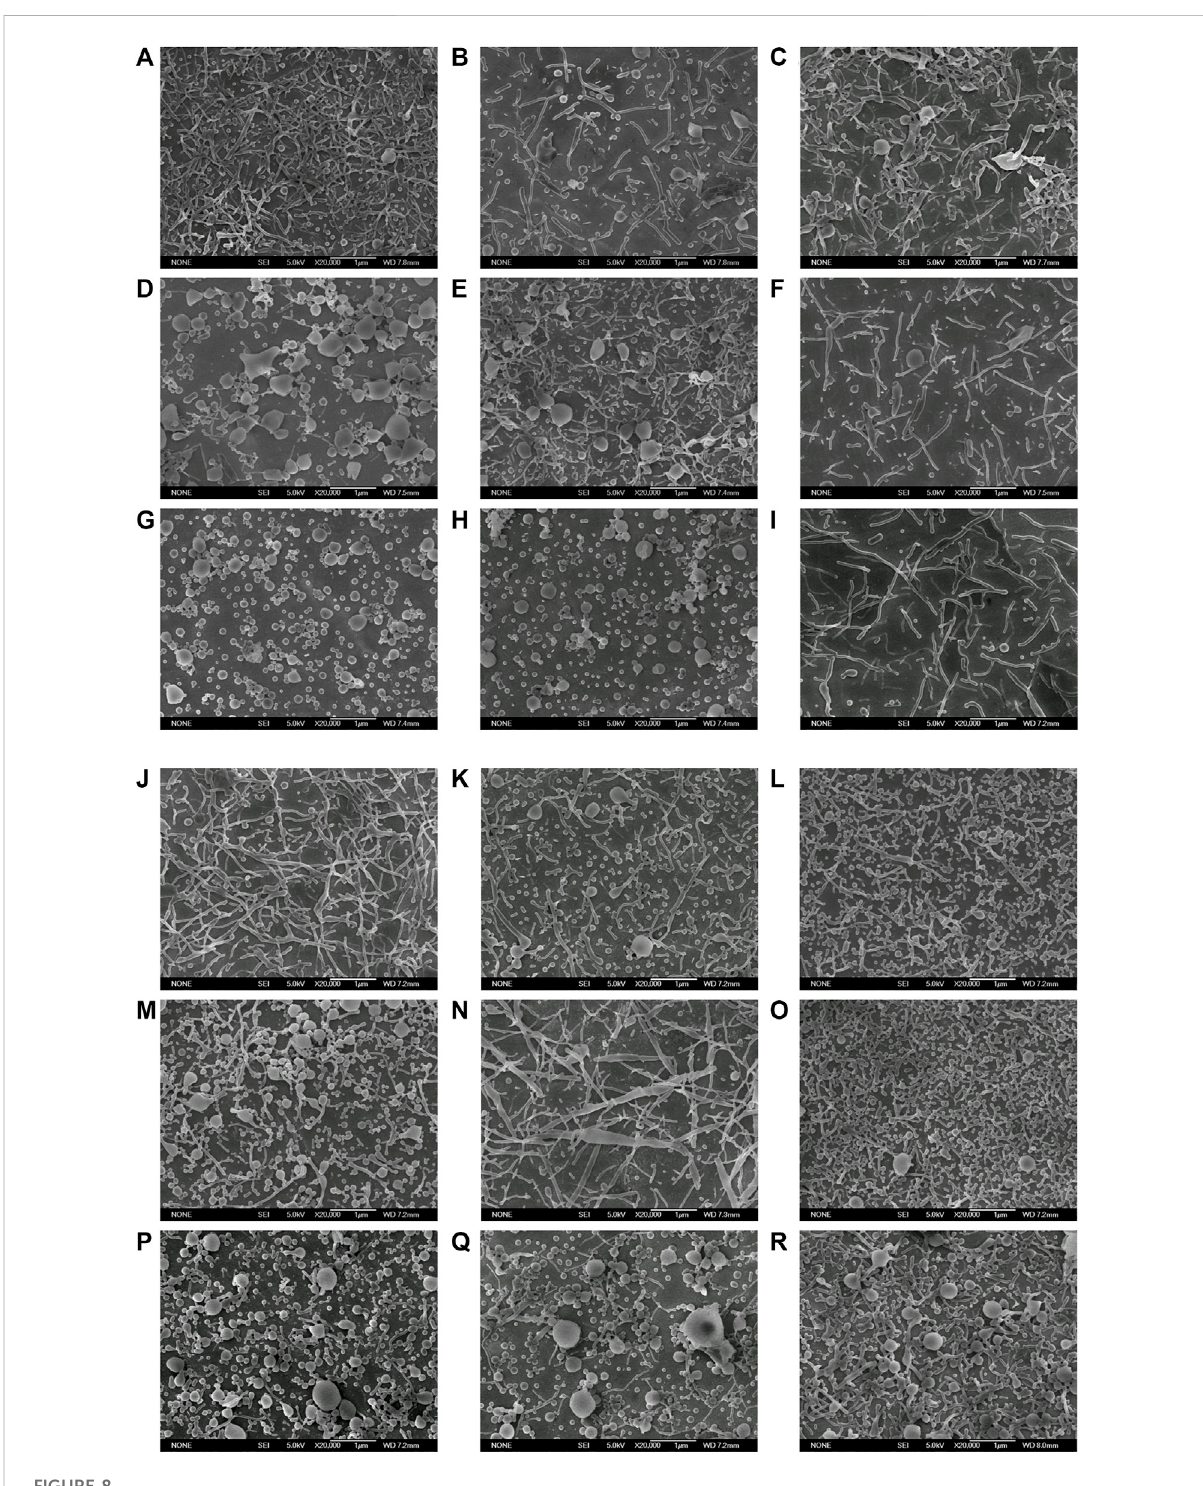
FIGURE 8 Electron micrographs of PLGA nanoparticles prepared with 18 orthogonally arranged tests for the six-factor three-level case (Scale bar: 1 μ m). (A – R) represented prescriptions 1 – 18 in Supplementary Table S2 respectively.